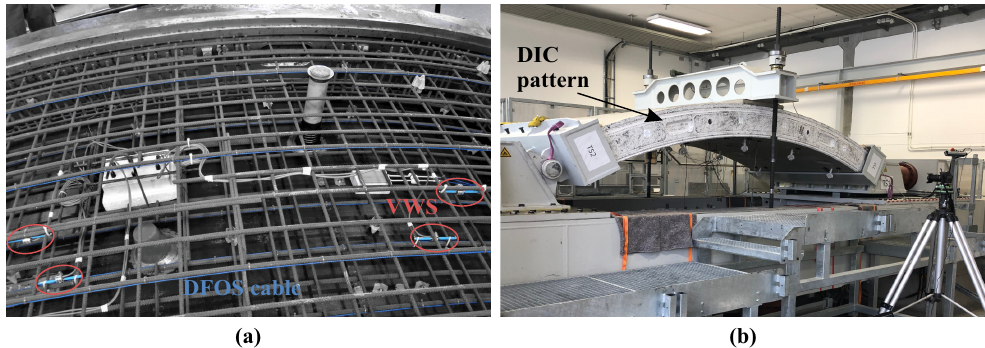
Figure 16. DFOS along precast tunnel lining segments: ( a ) Segment manufacturing. ( b ) Test